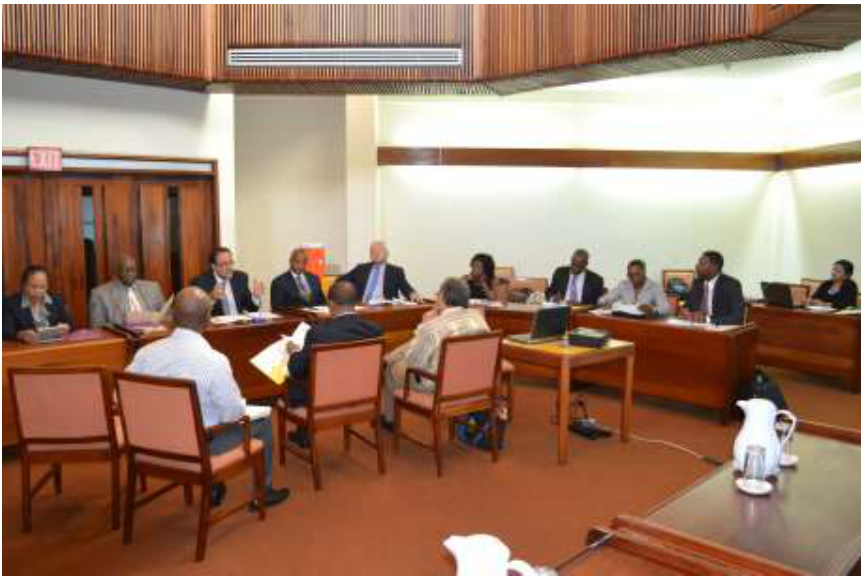
Figure 8: Parliamentarian cluster consultation, Justice for All Programme Workplace